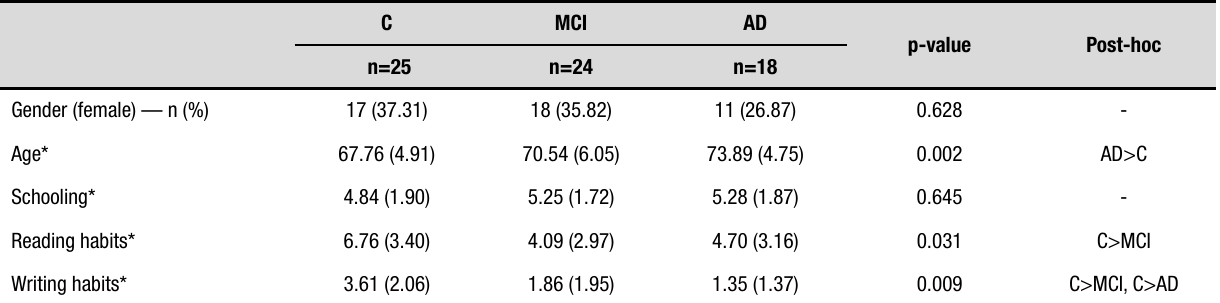
Table 1. Participants’ data on sociodemographic characteristics and reading/writing